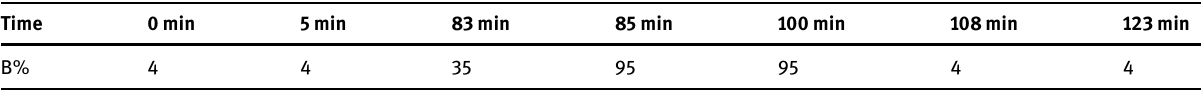
Table 1: Gradient pro fi le used for peptide C 188 separation